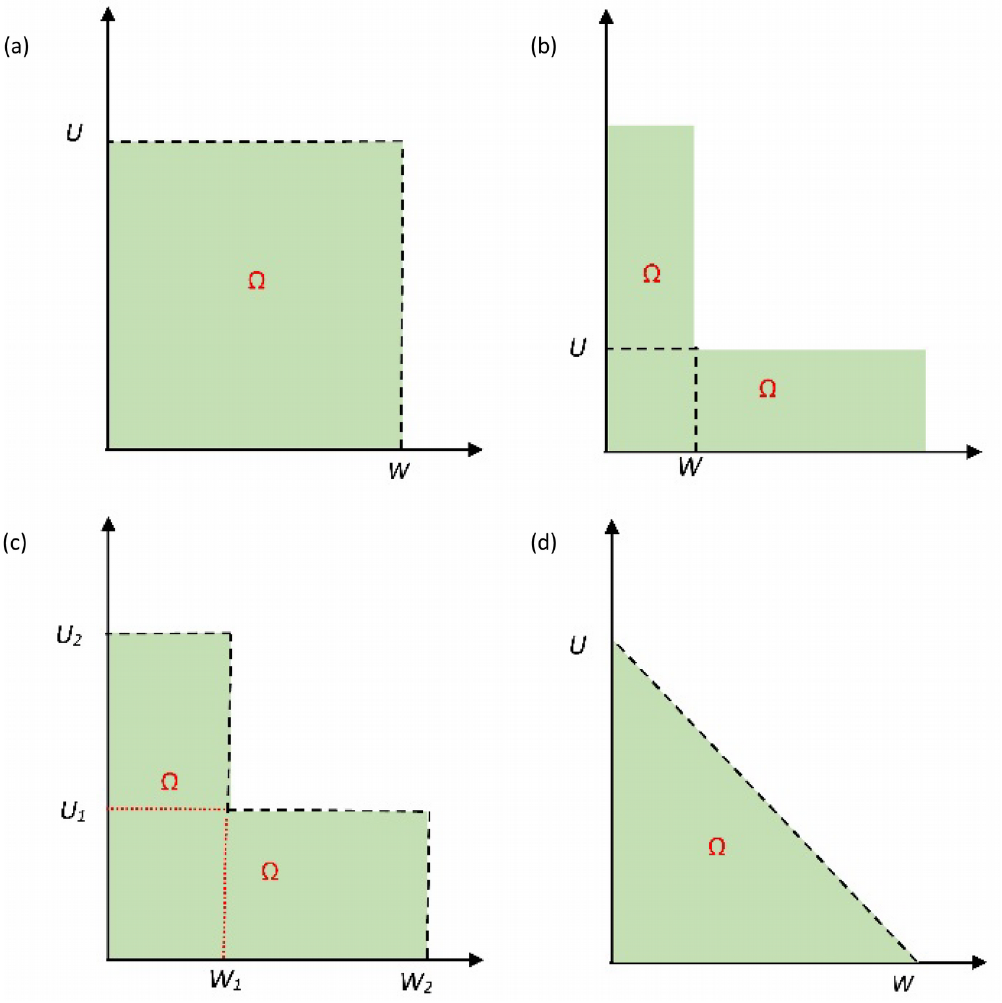
Figure 5. Warranty Regions for Renewing